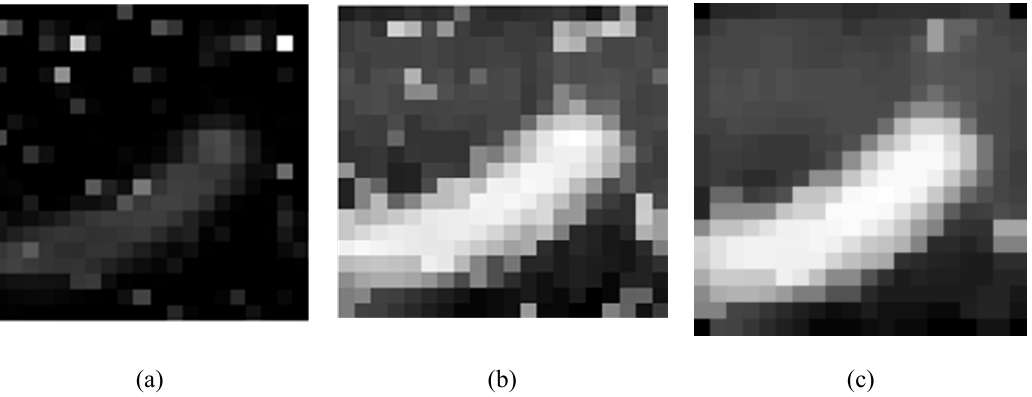
Figure 13. ( a ) Original Raman grayscale image. ( b ) Image processed by the Retinex theory. ( c ) Median filtered image.